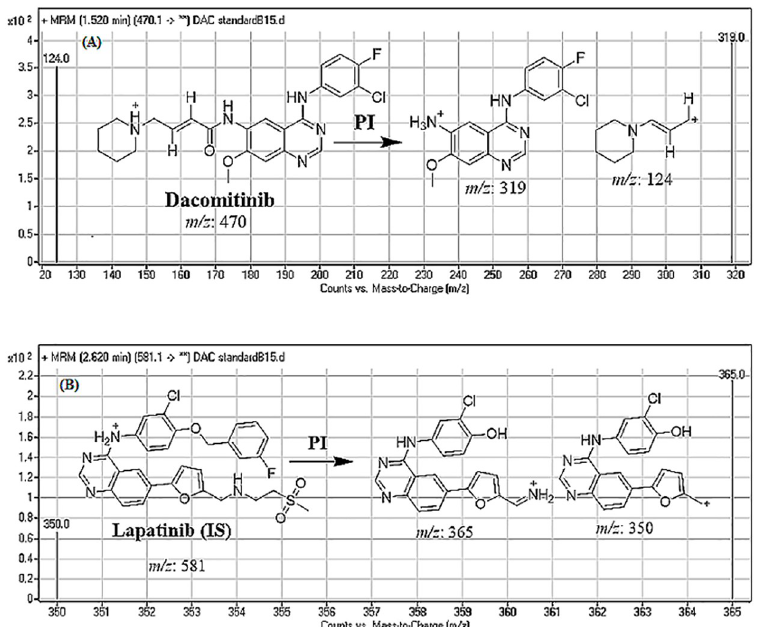
Fig 2. MRM mass spectrum transitions of DMB (A) and lapatinib (IS) (B).